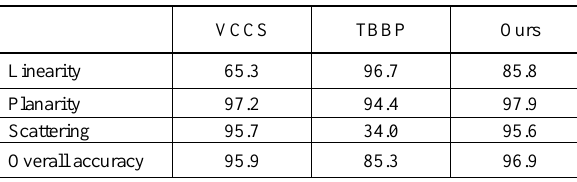
Table 2. Labelling accuracy (%) of the MLS test data based on supervoxels generated by different methods.